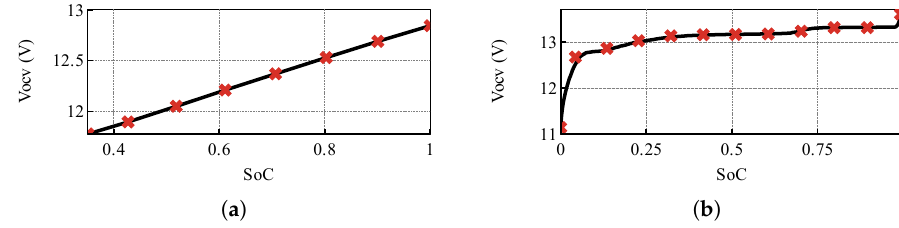
Figure 8. OCV vs. SoC curves of battery packs: ( a ) SLA battery pack. ( b ) LFP battery pack. The red markers represent the OCV points obtained with the pulse discharge test, and the black line is the curve obtained with a low current discharge